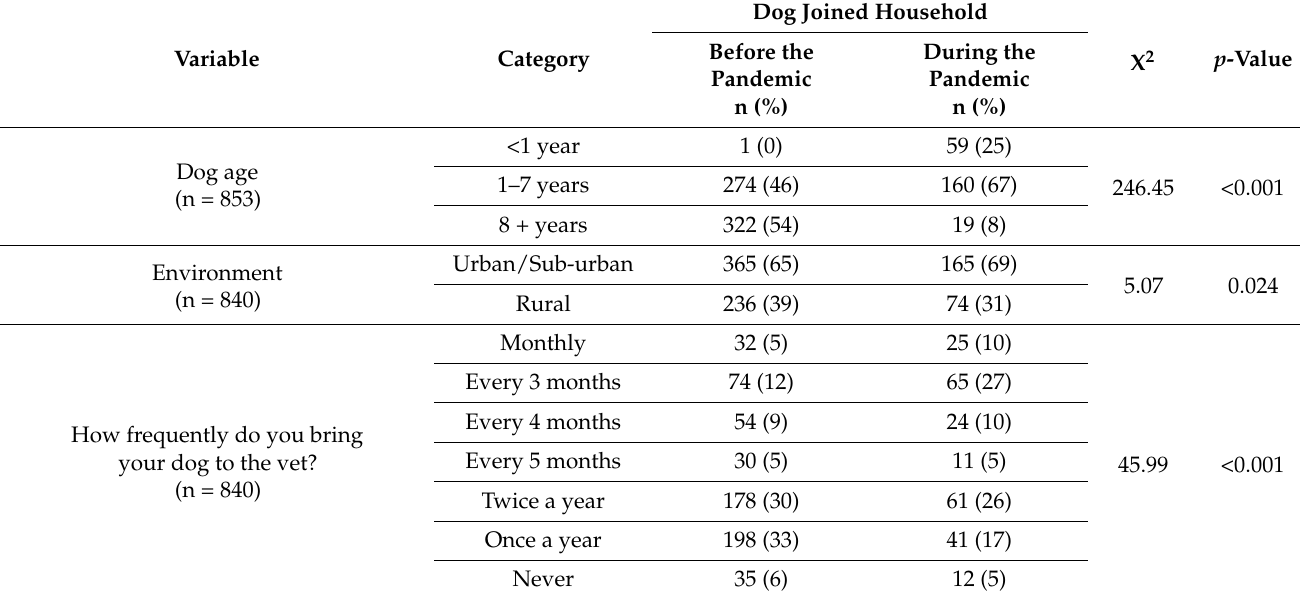
Table 7. Chi-squared (X 2 ) analysis for factors significantly associated ( p < 0.05) with owners getting their dog before or during the